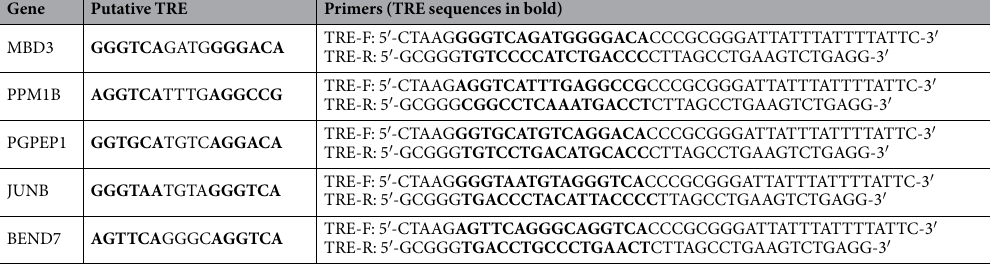
Table 1. Putative TREs and primers for generating the firefly luciferase